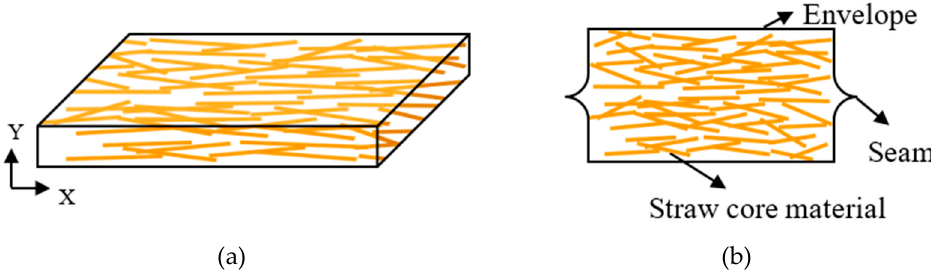
Figure 6. Schematic diagram of VIP with straw core material: 3D schematic diagram of VIP ( a ) and cross section of VIP ( b ).